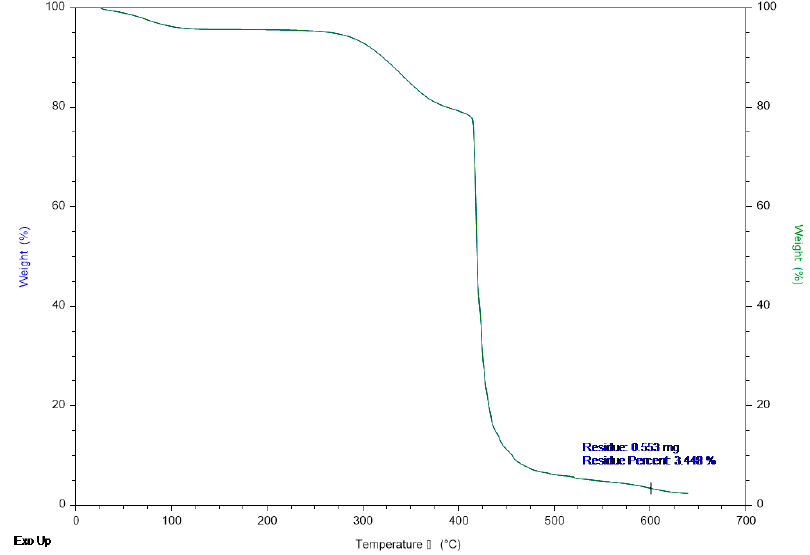
Figure 4. Thermogravimetric curve of MR 4 ‐ W . Table 2. CHN elemental analyses and metal loading.